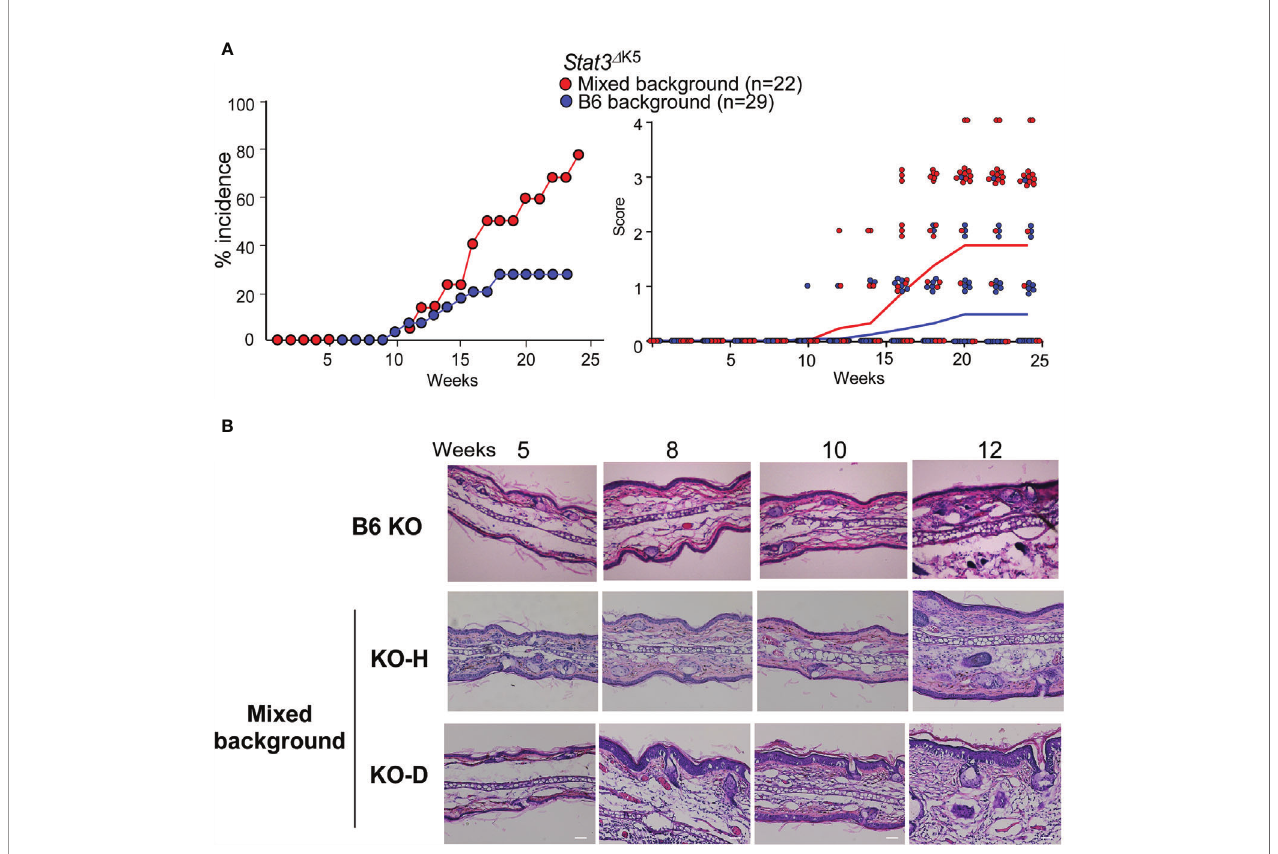
FIGURE 1 | Atopic dermatitis (AD)-like dermatitis frequently develops in mixed-background Stat3 D K5 mice. (A) Percentage of mixed- or B6-background Stat3 D K5 mice with skin lesions at indicated weeks of age (left). The clinical scores were analyzed for mixed (n=22) or B6 (n=29) background Stat3 D K5 mice at the indicated weeks of age (right). Line colors indicate means of clinical scores in each group. Clinical scores were determined as follows: 0, no lesion; 1, lesion on periocular area; 2, lesion on part of the face; 3, lesion on the whole face; 4, lesion on ear. (B) Skin hematoxylin and eosin staining images of non-onset B6 and mixed background healthy (KO-H) or onset (KO-D) Stat3 D K5 mice at indicated weeks of age. Scale bar = 100 m